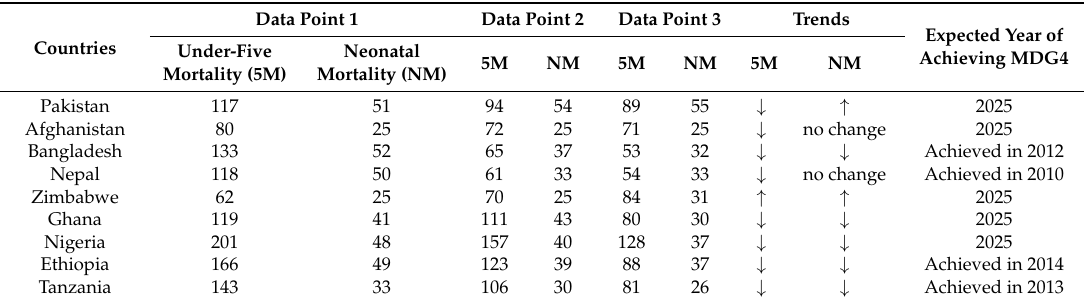
Table 2. Under-five and neonatal mortality rates from 1990 to 2013: Pakistan and eight countries from Asia and Africa tracking the fourth Millennium Development Goal (MDG4).